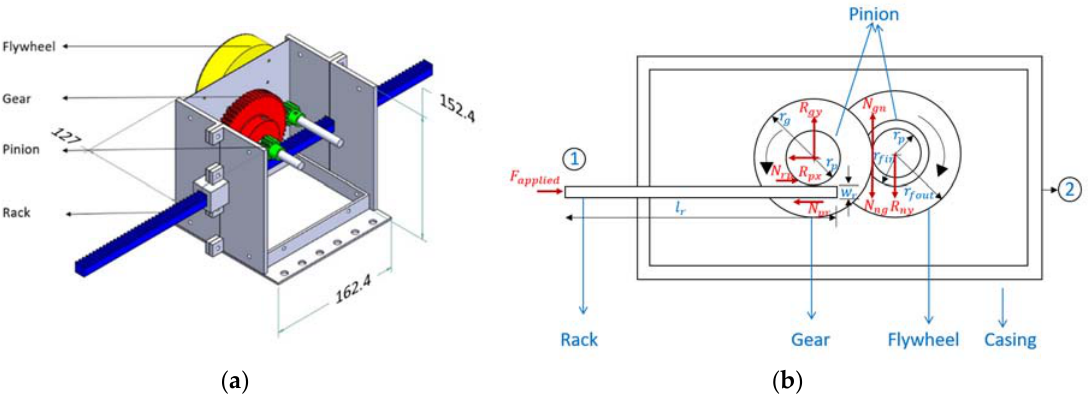
Figure 2. ( a ) CAD model of the rack-and-pinion inerter and ( b ) line diagram of the rack-and-pinion inerter showing forces and geometric parameters. All of the dimensions shown are in mm.